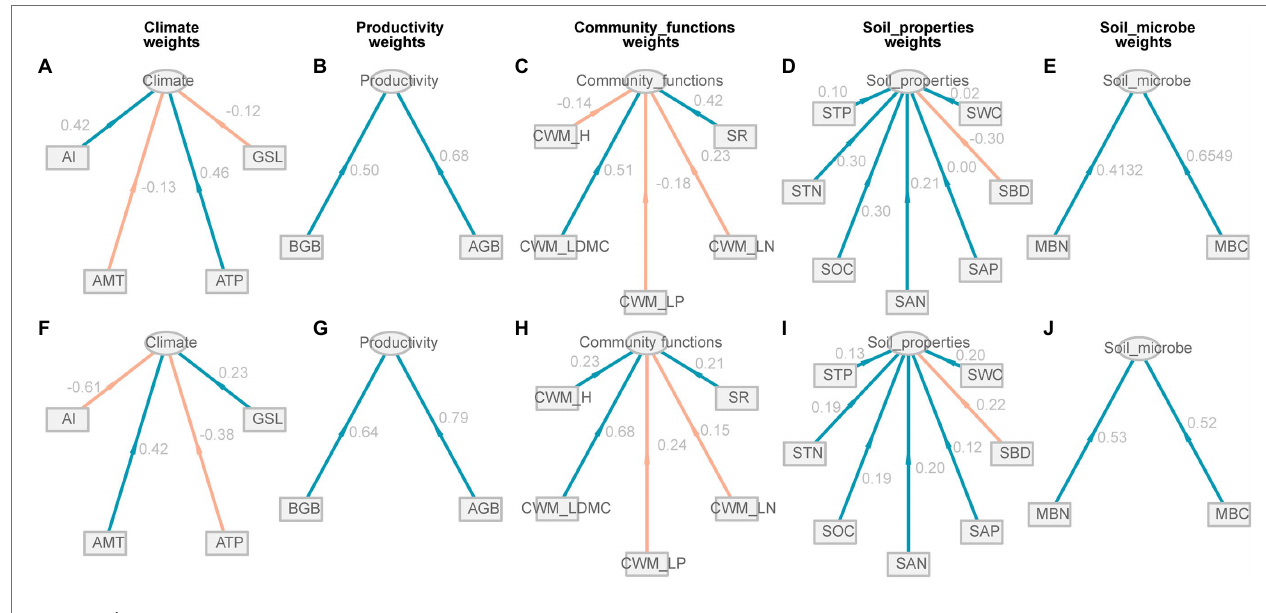
FIGURE 4 | Relationship between observed variables and potential variables of climate, productivity, community functions, soil properties, and soil microbial factors. (A–E) Low ecosystem multifunctionality conditions. (F–J) High ecosystem multifunctionality conditions. The value next to the line represents the path coefficient between observed variables and potential variables. Red lines represent the negative weights, and green lines represent the positive weights. GSL, the start of growing season to the peak of growing season; ATP, annual total precipitation; AMT, annual mean temperature; AI, aridity index; AGB, aboveground biomass; BGB, belowground biomass; SR, species richness; CWM_LN, community-weighted mean value of leaf nitrogen; CWM_LP, community-weighted mean value of leaf phosphorus; CWM_LDMC, community-weighted mean value of leaf dry matter content; CWM_H, community-weighted mean value of plant height;